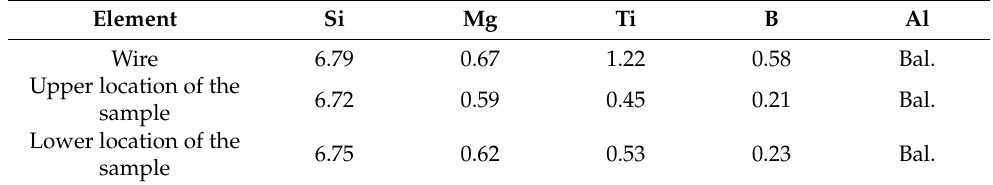
Table 1. Chemical composition of TiB 2 /AlSi7Mg0.6 wire and samples (mass fraction, wt%). Element Si Mg Ti B Al Wire 6.79 0.67 1.22 0.58 Upper location of the 6.72 0.59 0.45 sample Lower location of the sample